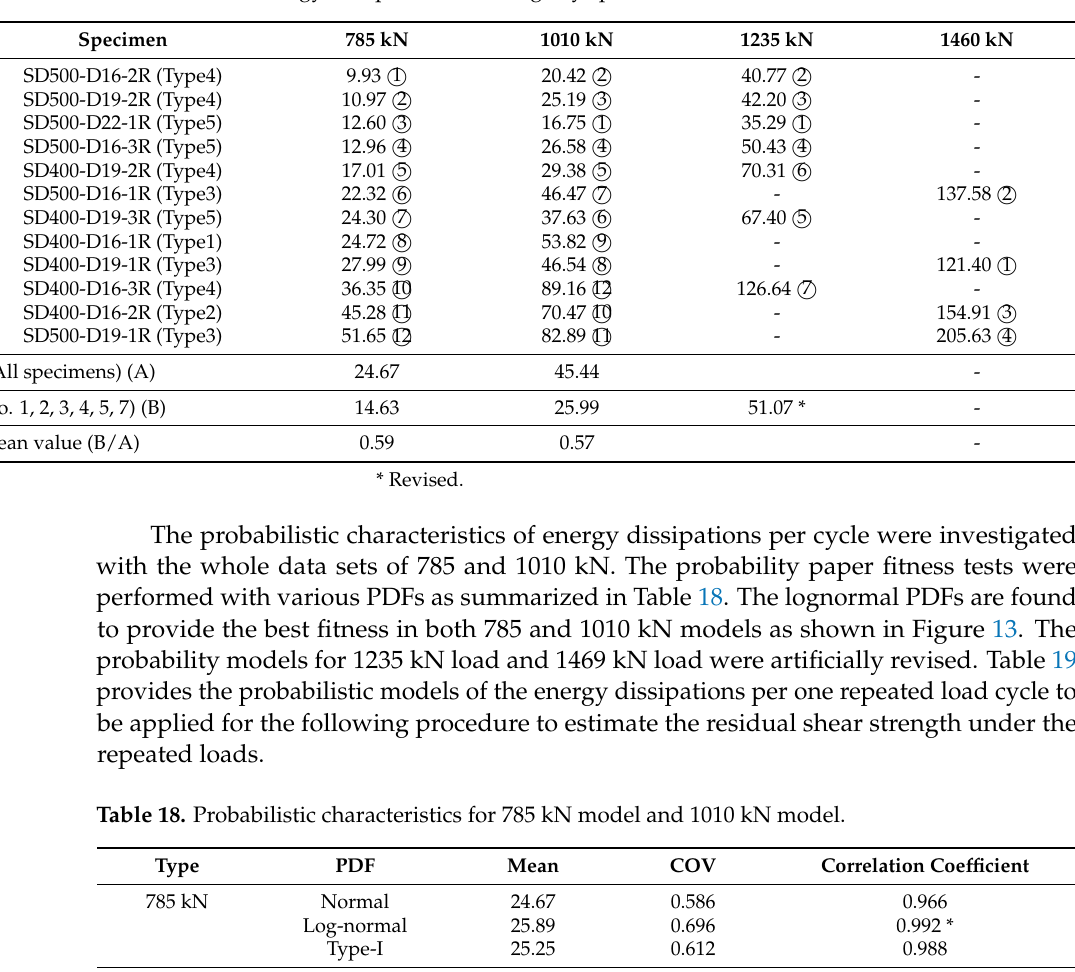
Figure 12. Energy dissipation changes by repeated loads. Table 17. Energy dissipation on average by specimen.